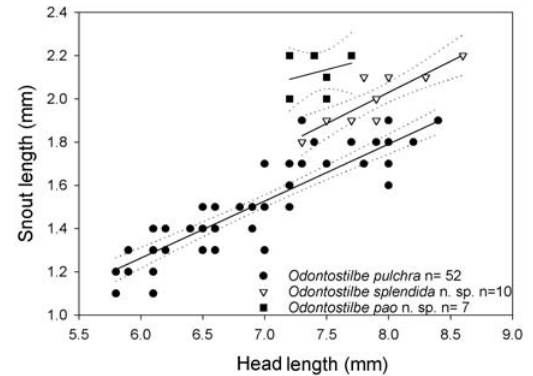
Fig. 3. Pectoral-fin length as a function of standard length for males of Odontostilbe pulchra , against O. fugitiva .